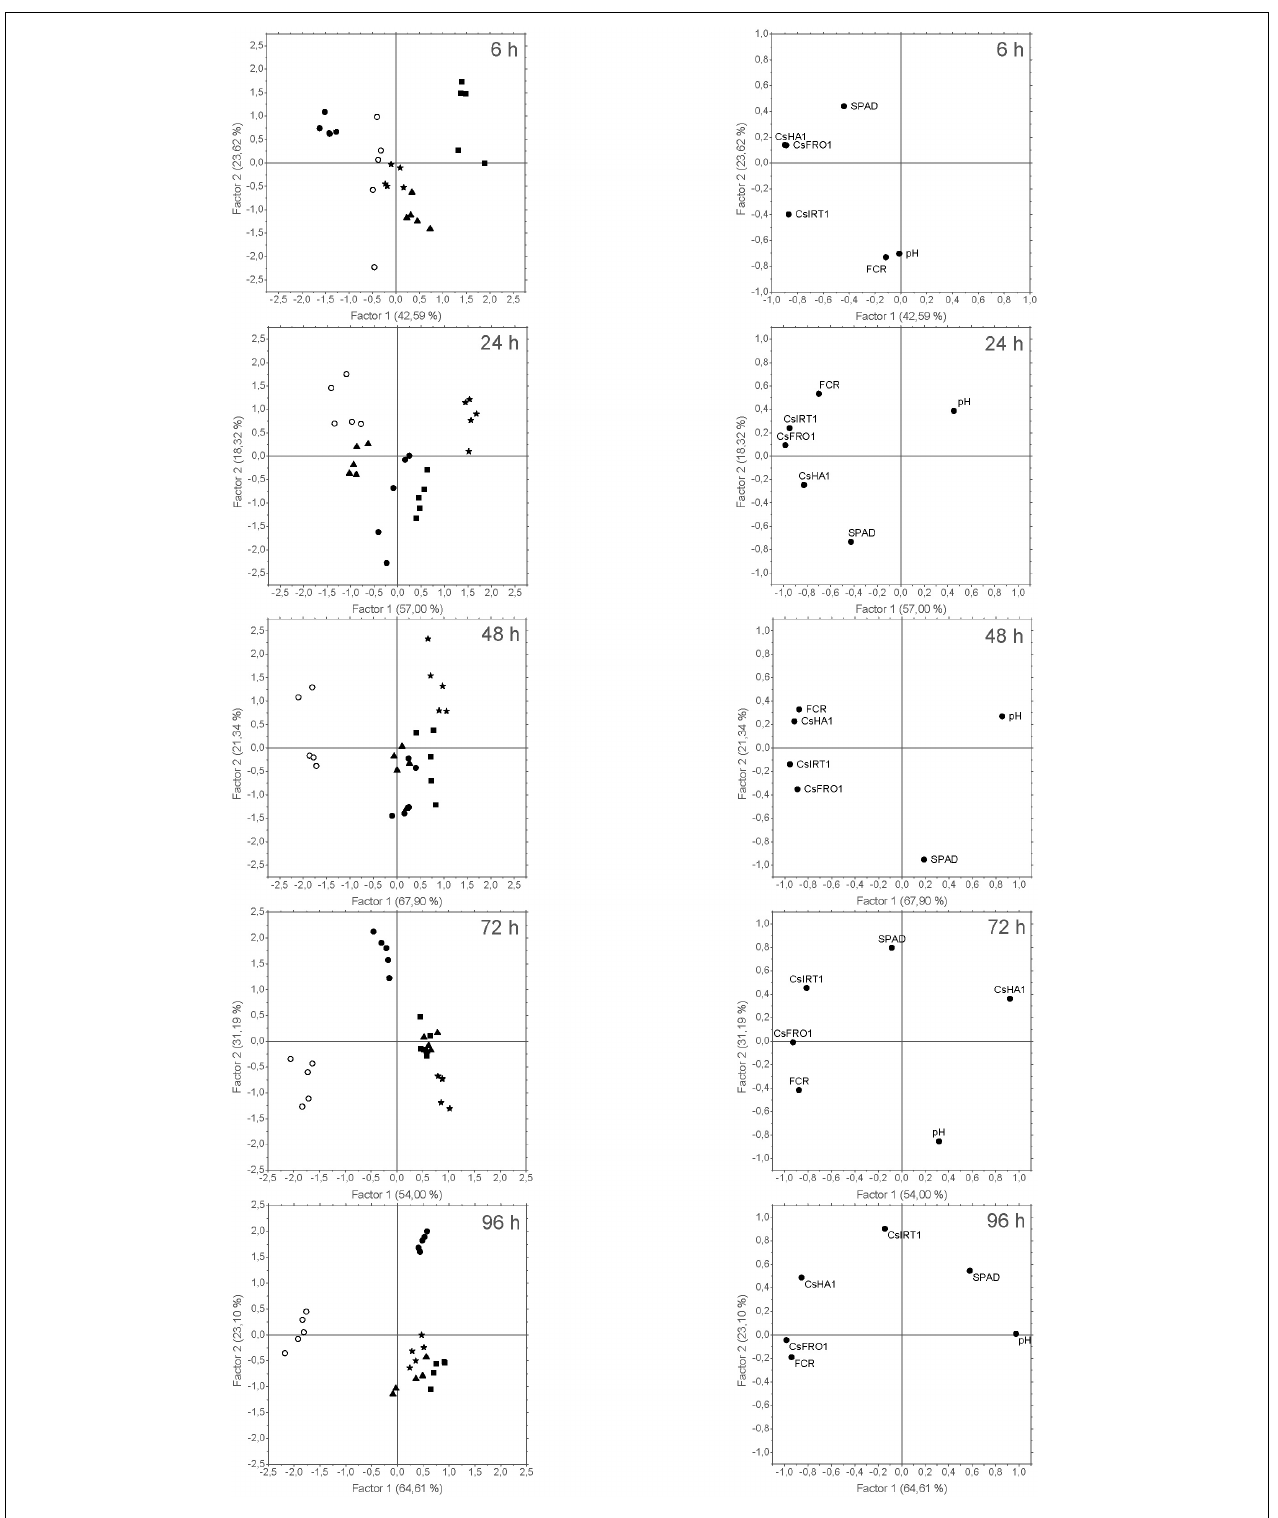
FIGURE 10 | Score plots of the cases (left) and loading plots of the variables (right) from the PCA of data derived from Experiment II. Five cases per treatment were considered: +Fe control ( ), –Fe control ( ), FeSO 4 ( (cid:4) ), HG ( (cid:78) ), and EDTA ( (cid:70) ). The variables introduced in the analysis were: SPAD values measured in leaves (SPAD); pH values measured in NS (pH); CsFRO1 , CsIRT1, and CsHA1 relative expression results (CsFRO1, CsIRT1, CsHA1); and FCR activity in roots (FCR). The (cid:32) (cid:35) number in brackets is the percentage of total variance explained by the